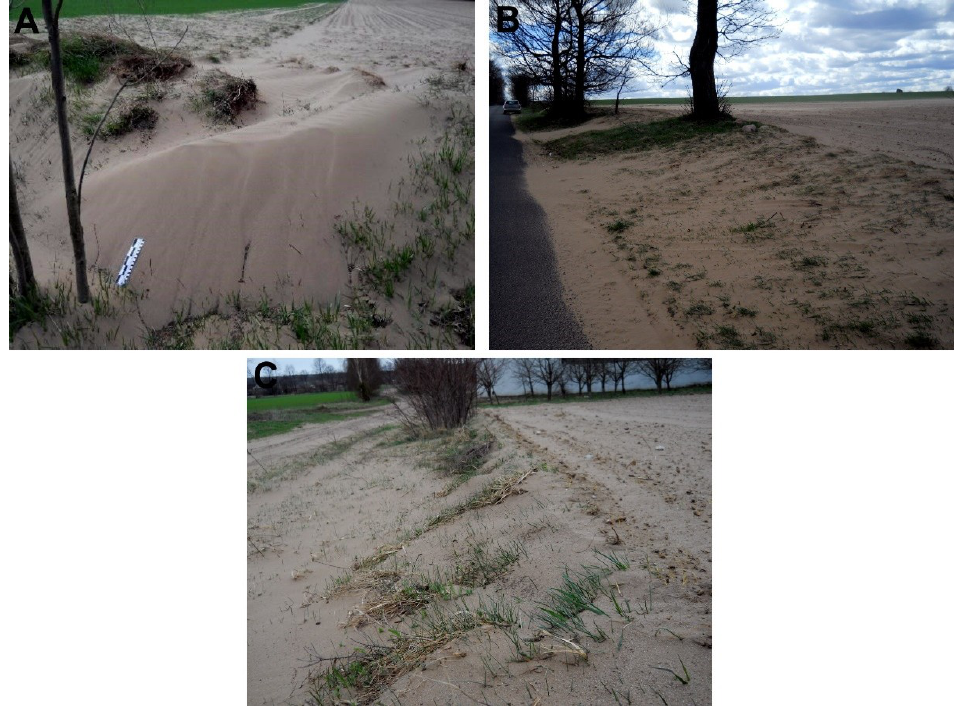
Figure 9. Aeolian accumulative forms in the research fields. A —drift; B —accumulation near trees (reduced); C —increased accumulation near shrubs (photos taken on 9 April, 2011).